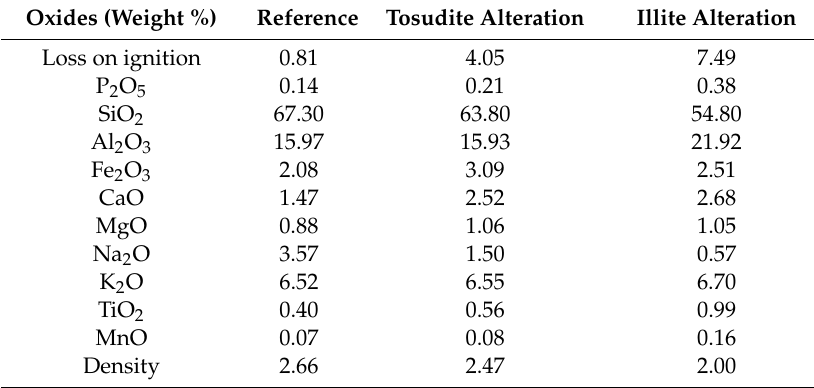
Table 2. Chemical composition of Soultz porphyritic granite: fresh facies (called Reference) and two altered facies (tosudite dominant and illite dominant). Modified after